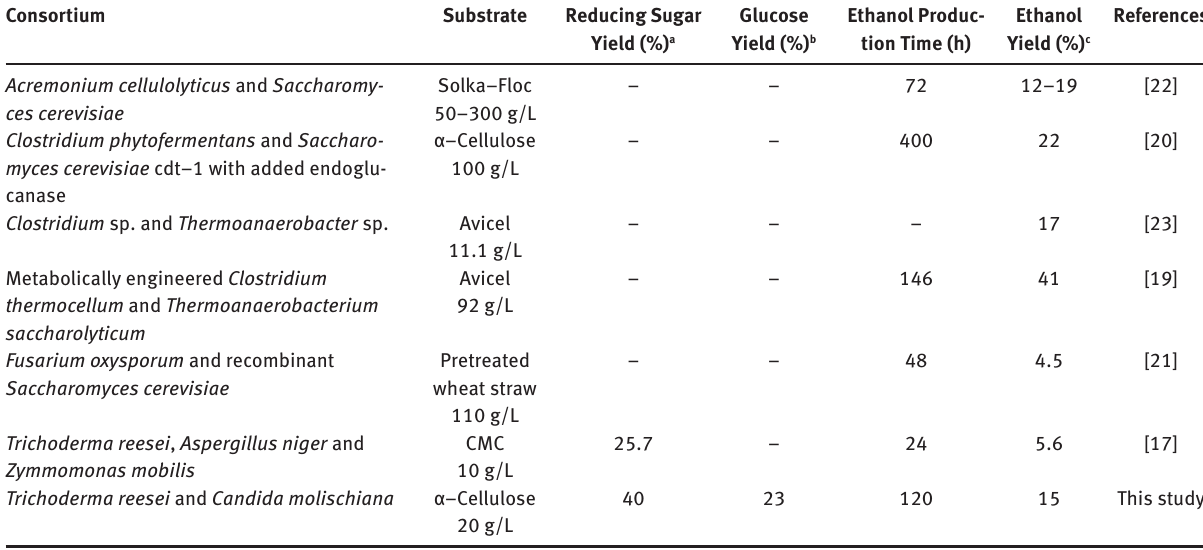
Table 1: Summary of ethanol production from cellulosic substrates by consortium of microorganisms.